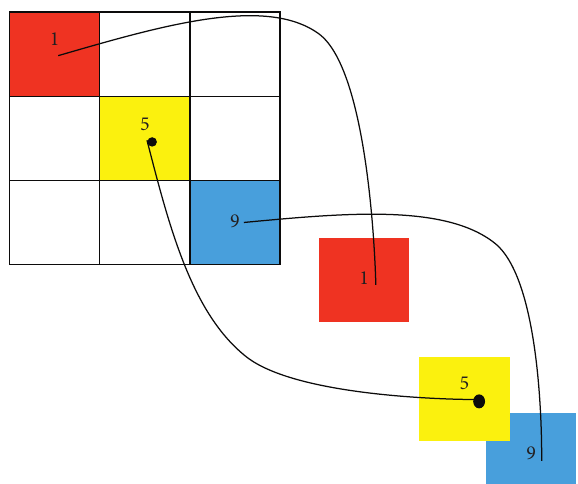
Figure 14: Schematic diagram of tracking results of segmented regions.